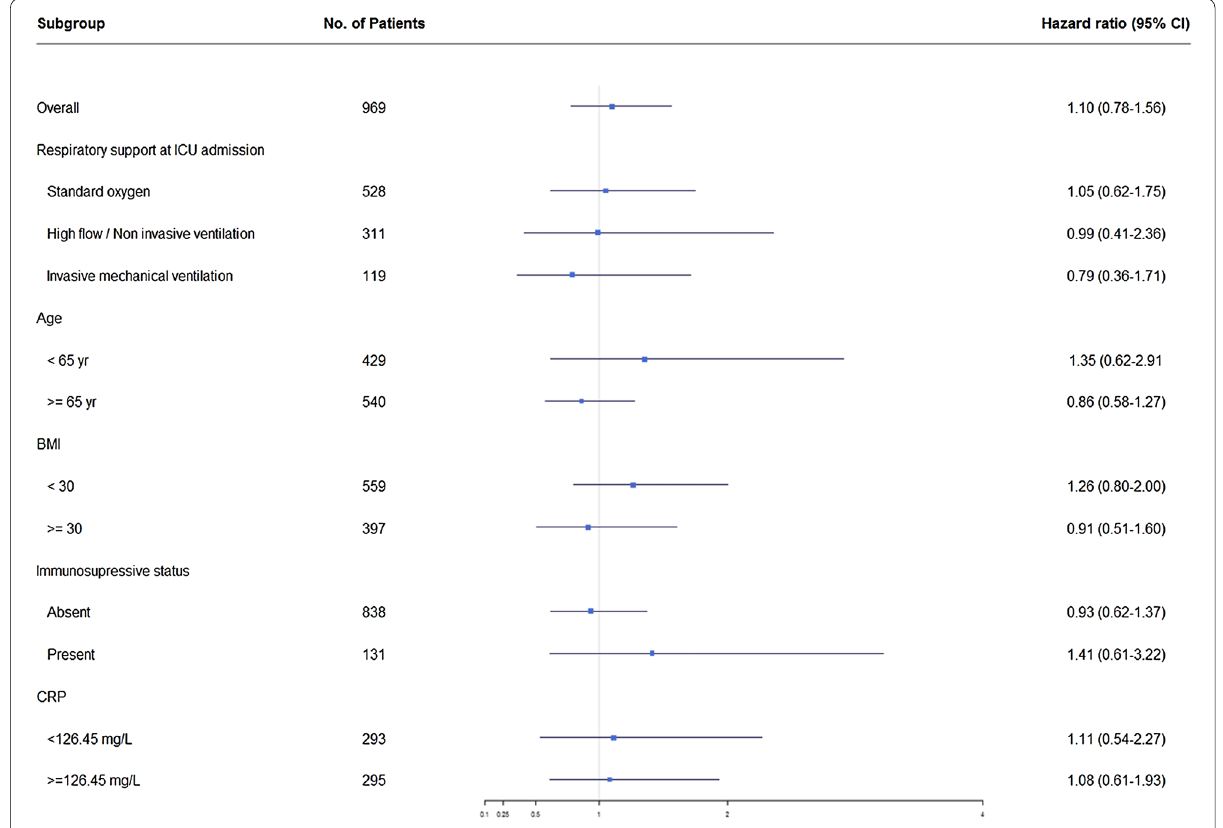
Fig. 3 Forest plot of the subgroup analysis for day‑28 mortality. BMI body mass index, CRP C‑reactive protein, ICU intensive care